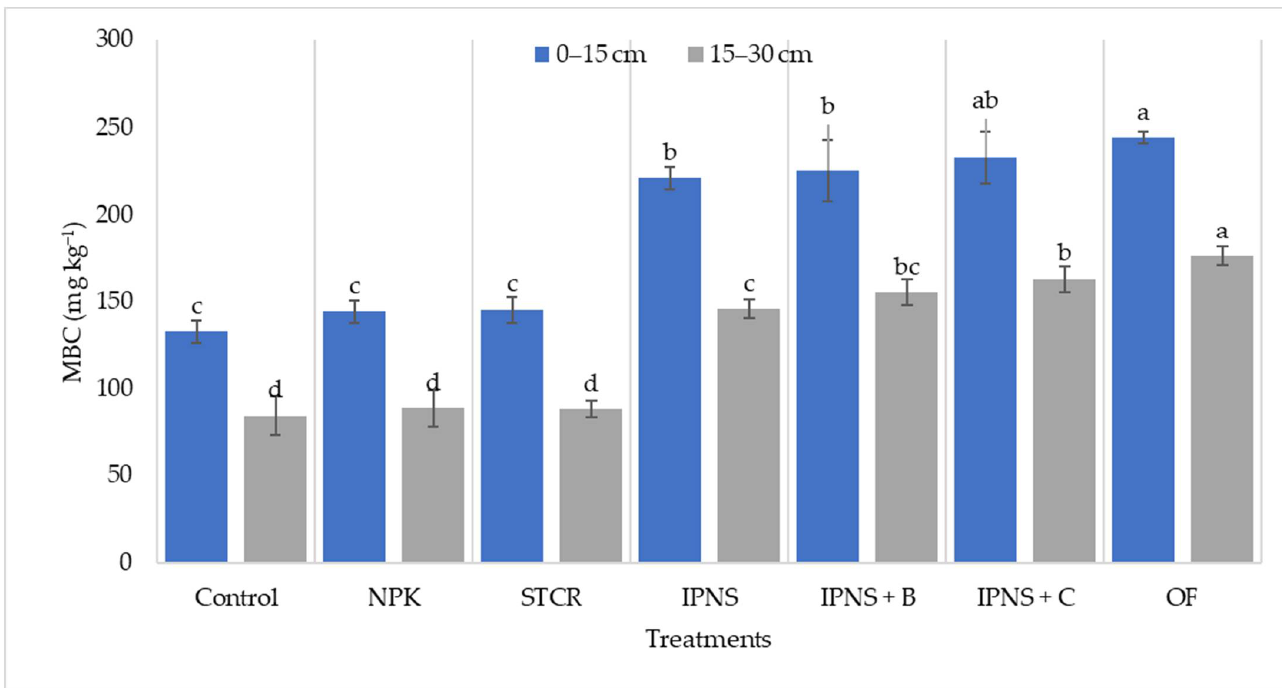
Figure 7. Effect of nutrient management on SMBC. Means ± standard deviation of different treat- ments followed by the different lower-case letter (a–d) are significantly different at p < 0.05 level of significance according to DMRT.